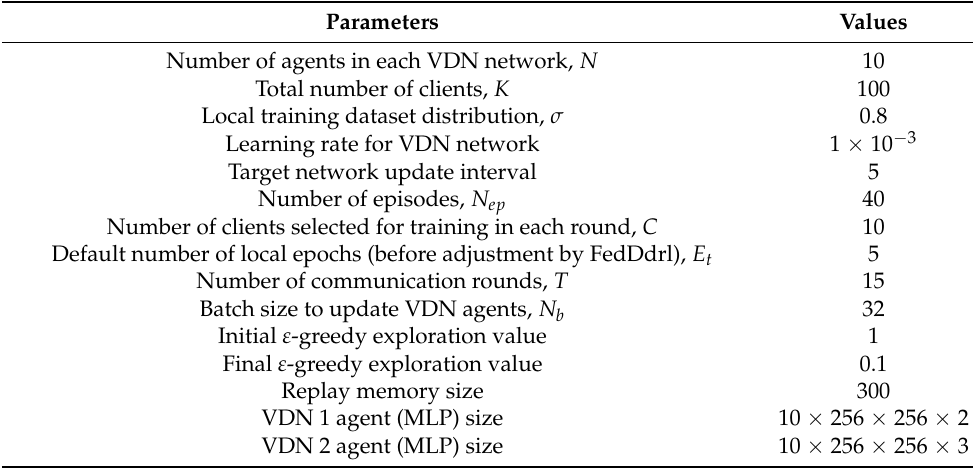
Table 3. List of hyperparameters. Parameters Values Number of agents in each VDN network, N 10 Total number of clients, K 100 Local training dataset distribution, σ 0.8 Learning rate for VDN network 1 × 10 − 3 Target network update interval 5 Number of episodes, N ep 40 Number of clients selected for training in each round, C 10 Default number of local epochs (before adjustment by FedDdrl), E t 5 Number of communication rounds, T 15 Batch size to update VDN agents, N